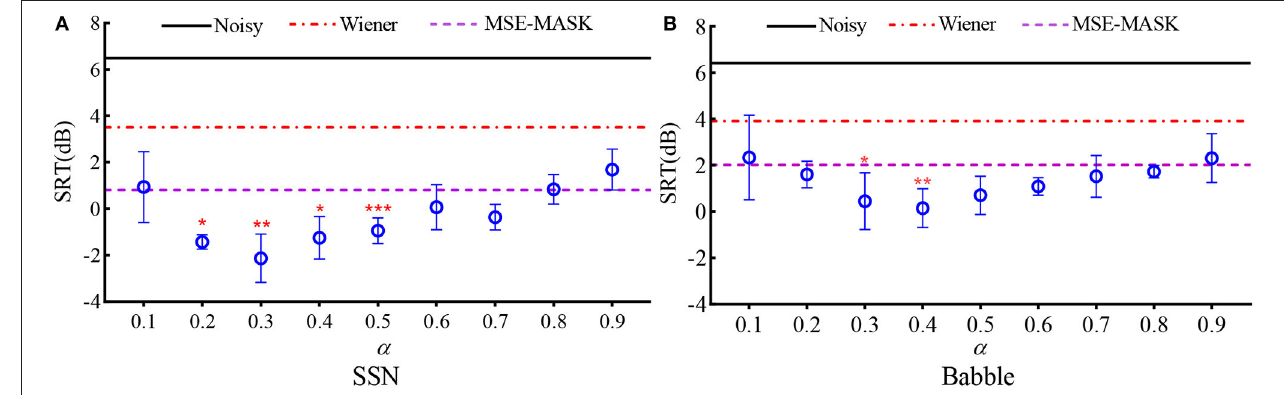
FIGURE 7 | SRTs for different SE front ends with the vocoded speech, (A) SSN and (B) Babble. The circles represent the means, and the error bars represent the standard deviations for each WL-MASK. The asterisk represents the result of pairwise comparison of MSE-MASK and WL-MASK, * indicates p < 0.0332, ** indicates p < 0.0021, and *** indicates p <